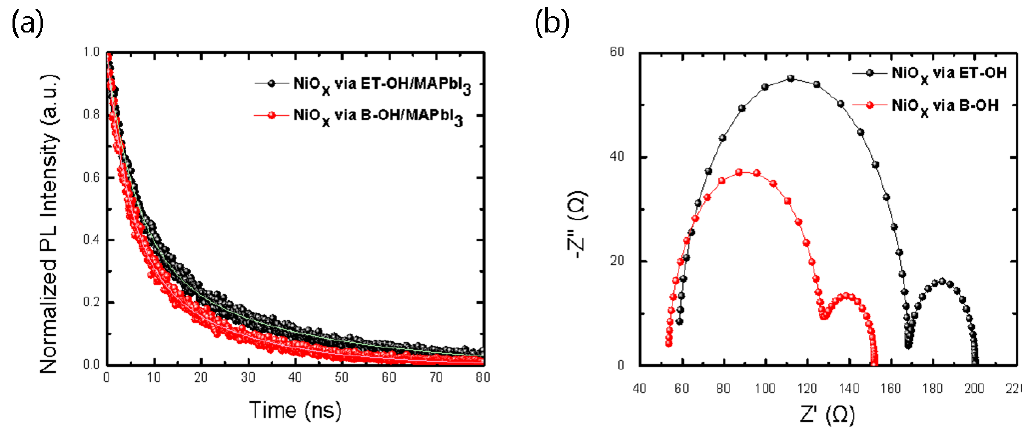
Figure 5. Normalized photoluminescence spectra of the glass/NiO x (sol-gel) via solvent (ET-OH, B-OH, and P-OH)/perovskite(MAPbI 3 ) film under 550 nm light excitation respectively.